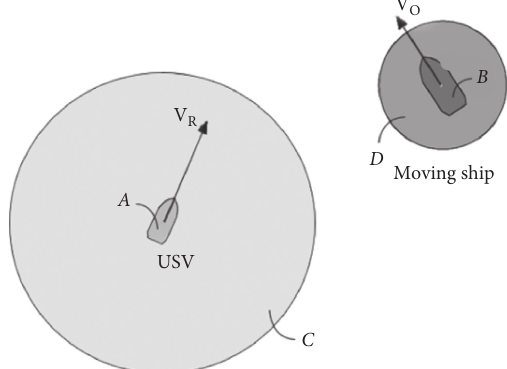
Figure 1: The motion model of the intelligent ship and an obstacle boat.